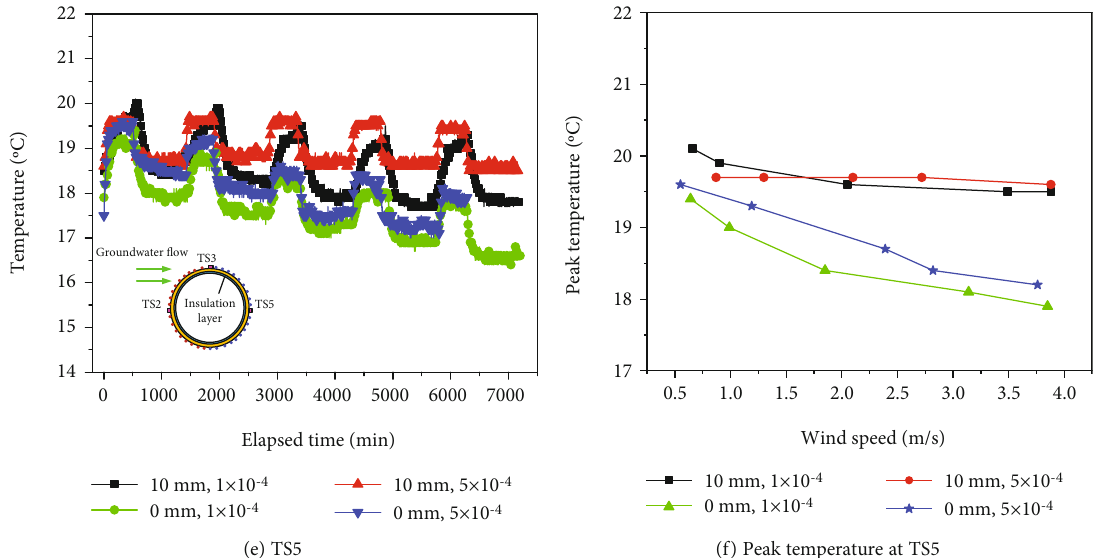
Figure 7: In fl uence of the insulation layer on the interface temperature variation between lining and surrounding rock at di ff erent